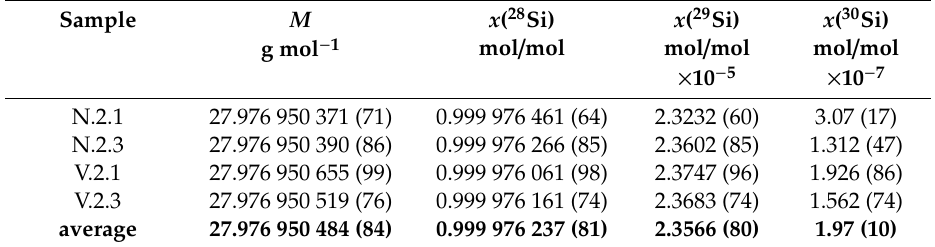
Figure 3. Molar masses M of the four crystal samples (Si28-33Pr11) investigated in this study. For each average value, the combined uncertainty ( k = 1) is given by error bars. The average value (arithmetic mean) of all measurements is M (Si) = 27.976 950 48 (16) g / mol (solid line). The average relative uncertainty is u rel ( M ) = 5.7 × 10 − 9 including the contributions of data scattering. Table 2. Average molar masses and amount-of-substance fractions (isotopic composition) of different samples (Si28-33Pr11). Numbers in brackets denote uncertainties in the last digits. Uncertainties ( k = 1) do not cover data scattering.